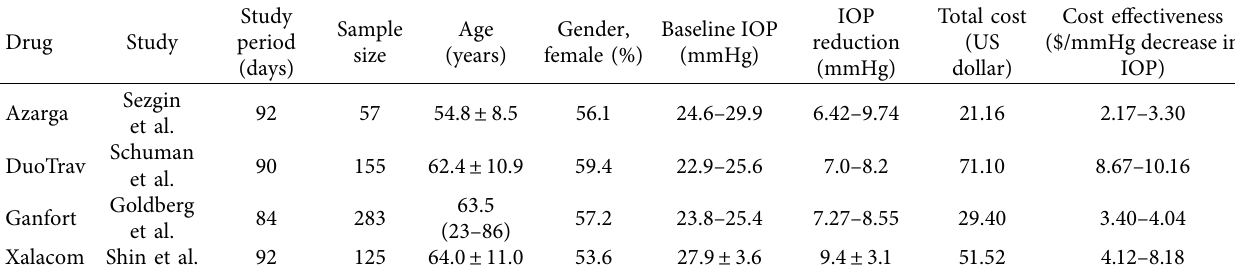
Table 3: The cost effectiveness of glaucoma fixed